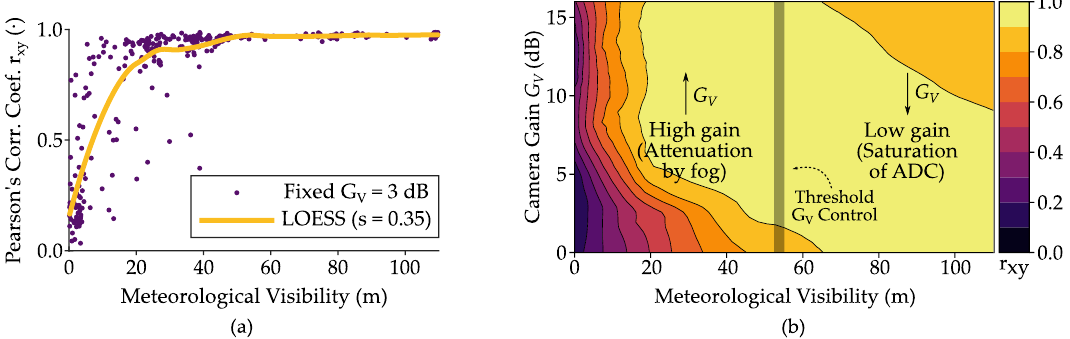
Figure 7. Results using the Pearson’s correlation coefficient between reference signal and images taken in Experiment 1.2 under different visibility conditions. ( a ) Scatterplot of the r xy values obtained using fixed gain of 3 dB. The red line is the non-parametric locally estimated scatterplot smoothing (LOESS) of span = 0.35 [52]. ( b ) Contour plot LOESS of span = 0.15 of r xy values changing the camera gain. The shaded vertical line corresponds to a fuzzy threshold determined by the analog gain control